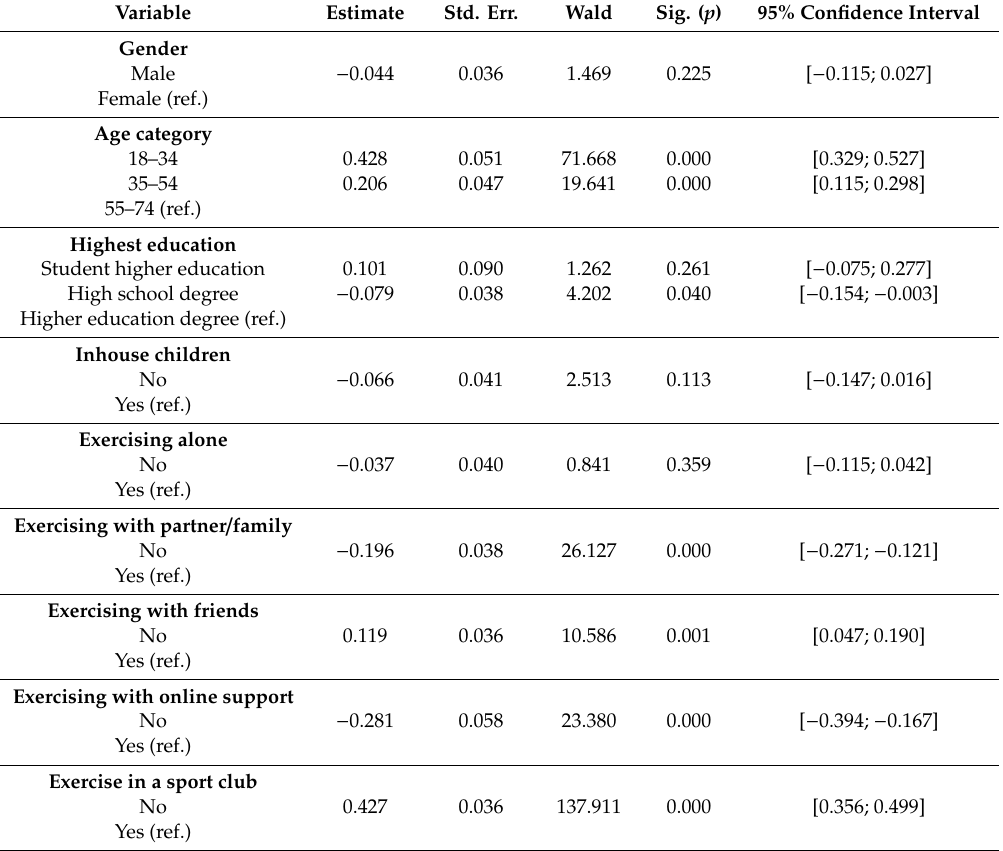
Table 2. Output ordinal logistic regression analysis of the influence of demographic and exercise-related determinants on exercising less, as much, or more (subsample high active people, n =